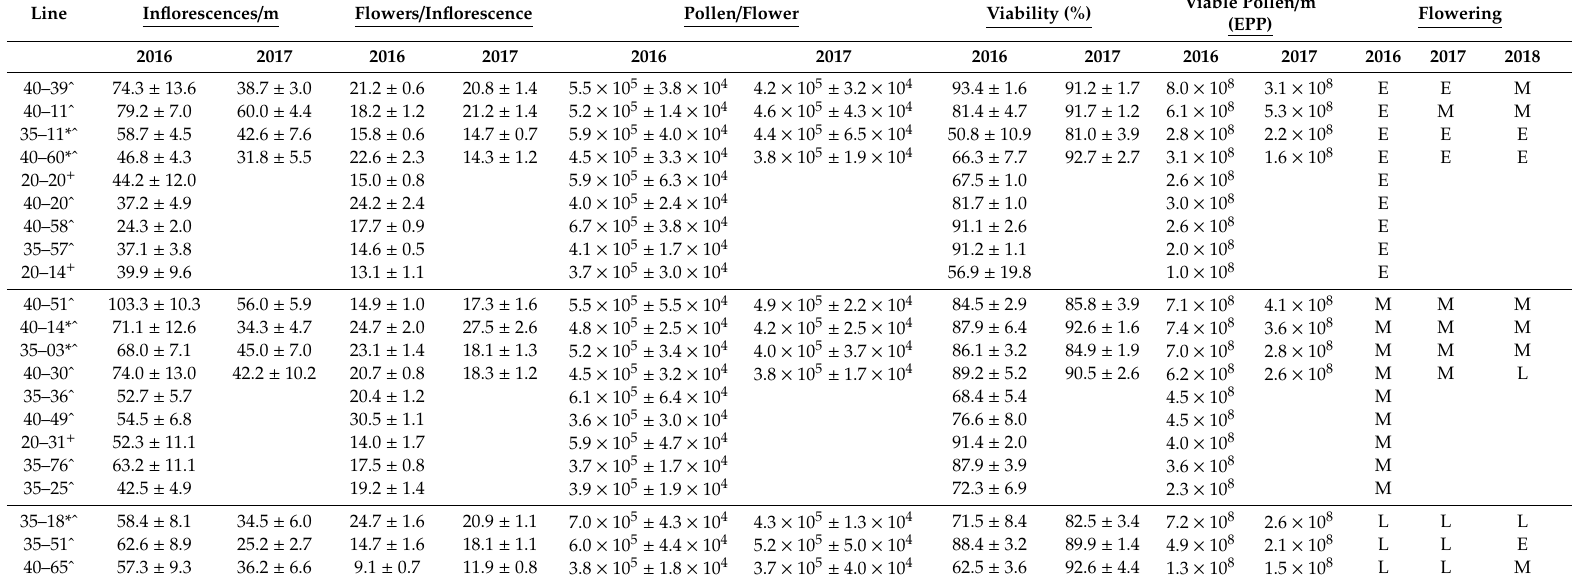
Table 1. Flowering and floral traits of selected male jojoba seedlings in 2016, 2017, and